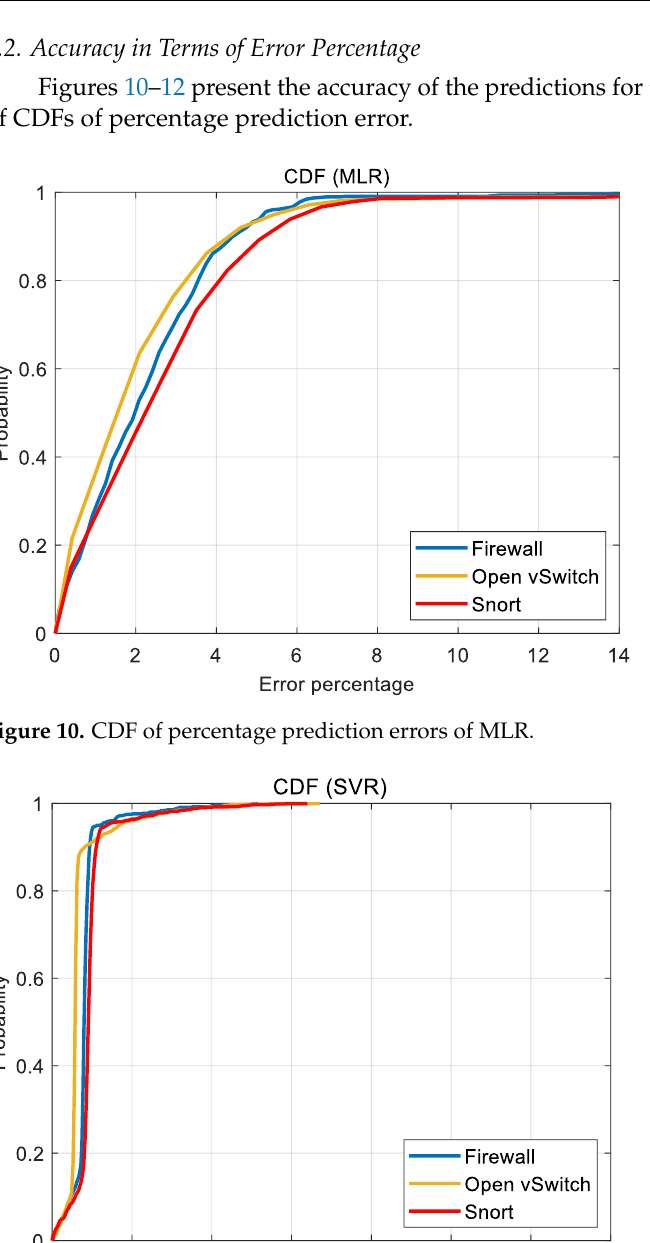
Figure 11. CDF of percentage prediction errors of SVR.